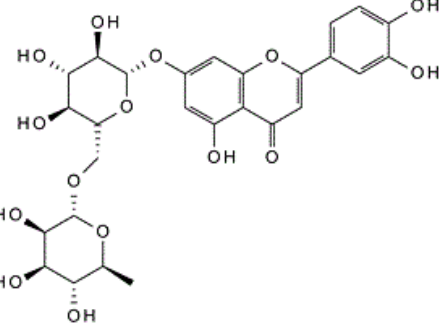
Figure 1. Chemical structure of luteolin ‐ 7 ‐ O ‐ rutinoside (Cas No: 20633 ‐ 84 ‐ 5).